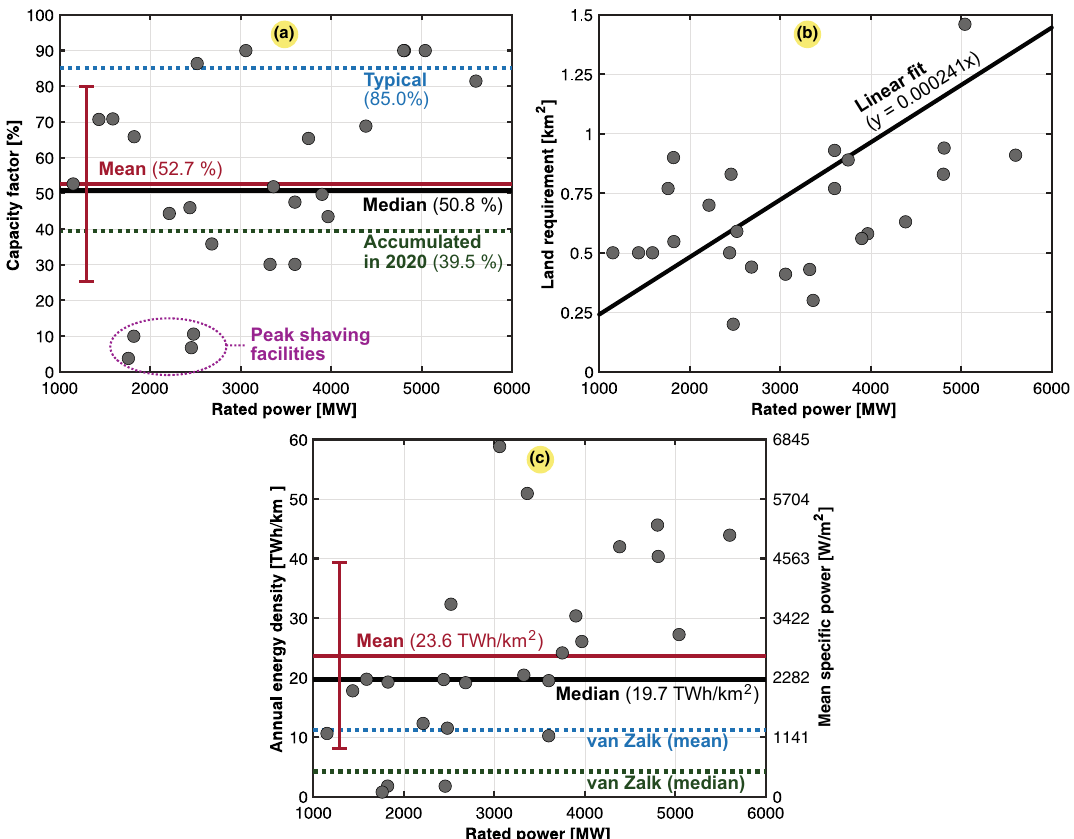
Figure 2. Scatter plots of 26 large- and medium-sized natural gas combined-cycle electric power plant facilities in the world (13 in the US, 5 in Japan, 4 in Russia, 2 in the United Arab Emirates, and 2 in Vietnam). Typical, mean, median, and fitted values are also included. The subplots are as follows: ( a ) capacity factor ( C g ); ( b ) land use ( A g ); and ( c ) annual energy density ( ε g ) or mean specific power ( p g ) excl. pipelines with van Zalk and Behrens 3 as a reference. Mean specific power ( p g )